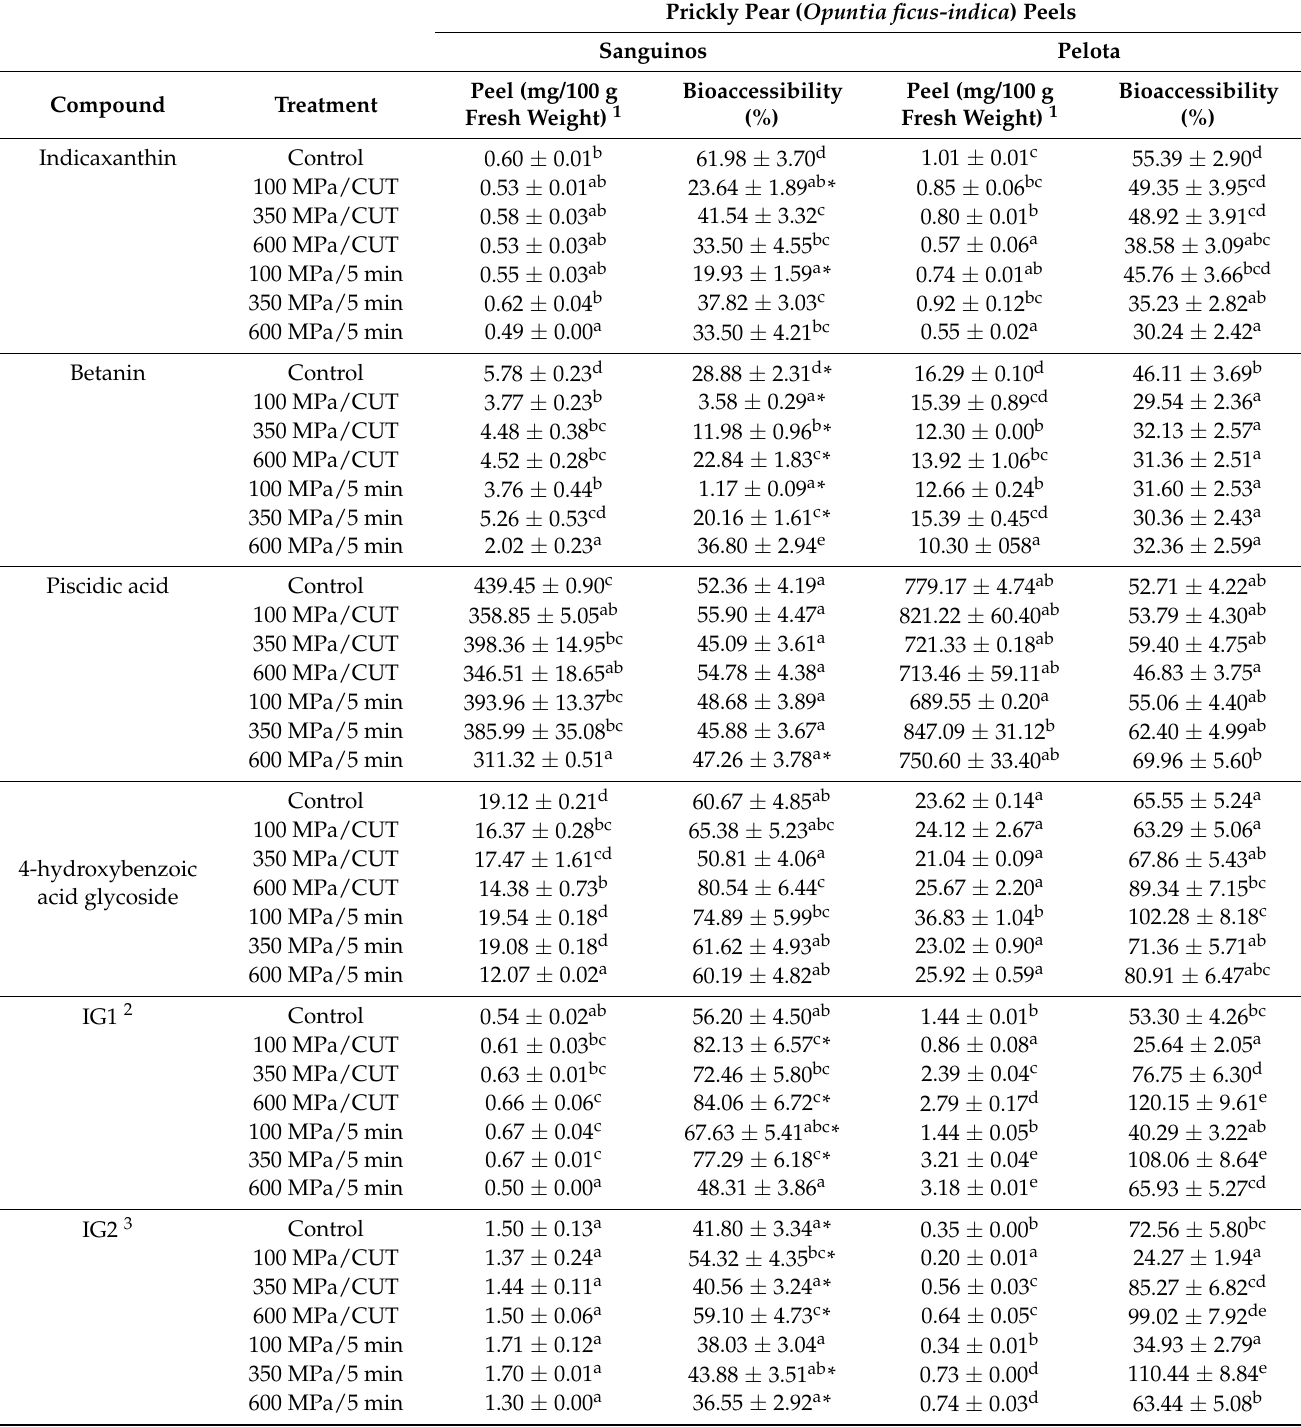
Table 3. Initial content (mg/100 g weight) and in vitro bioaccessibility of betalains and phenolic compounds in HHP-treated (100 MPa, 350 MPa, 600 MPa; CUT and 5 min) Sanguinos and Pelota prickly pear peels and in untreated (control)